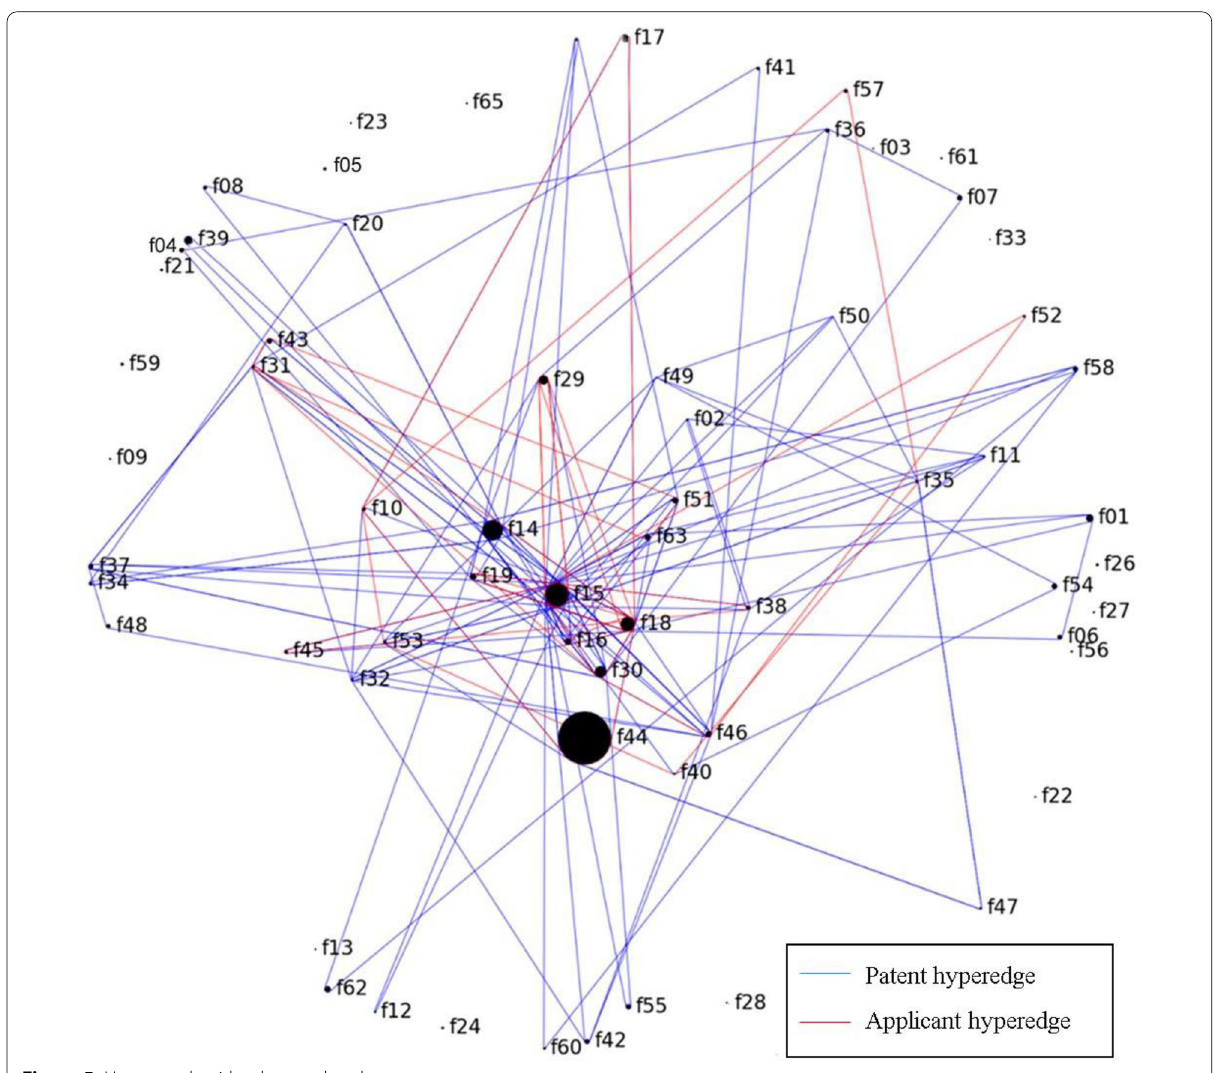
Figure 5 Hypergraph with edges and nodes